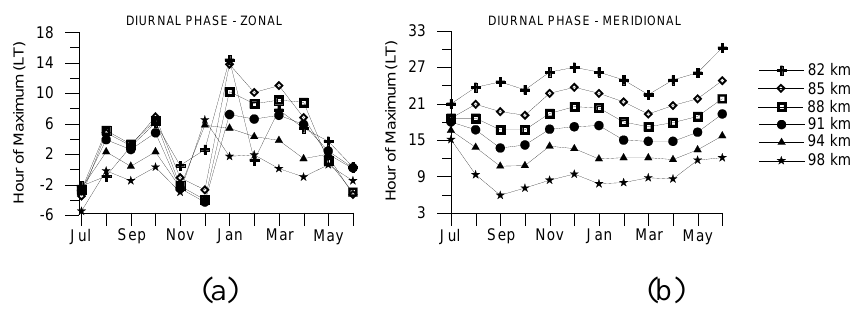
Fig. 5. Hour of maximum (Local Time) for zonal (a) and meridional (b) diurnal oscillations from July 2004 to June 2005.